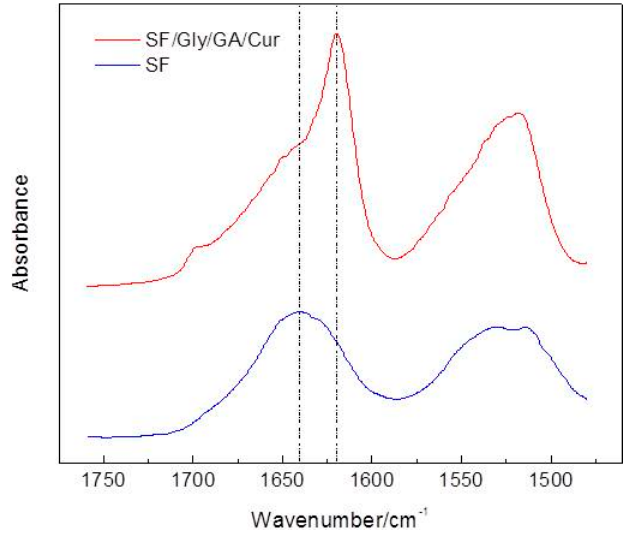
Figure 7. Zoom-in of Figure 6a,b for the region from 1480 cm − 1 to 1760 cm − 1 .